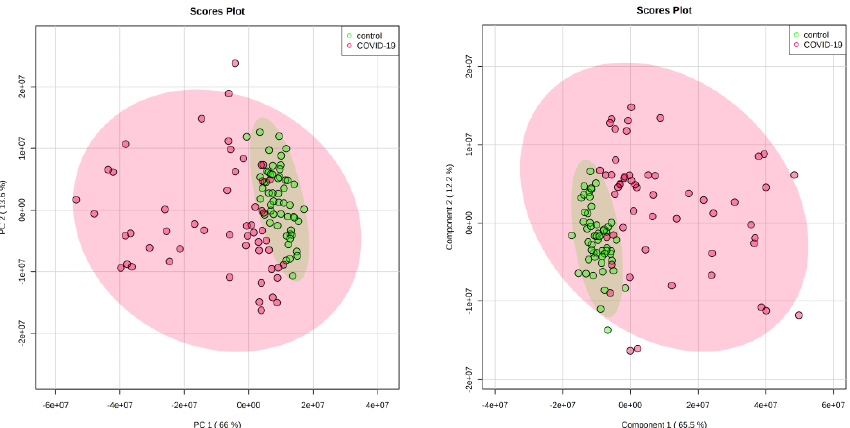
Figure 1. PCA ( left ) and PLD-DA analyses ( right ) of the system: patients in the hospital on Day 1 versus controls; algorithms were fed by the relative concentrations of plasma metabolites, and analyses were run in metaboanalyst [16].